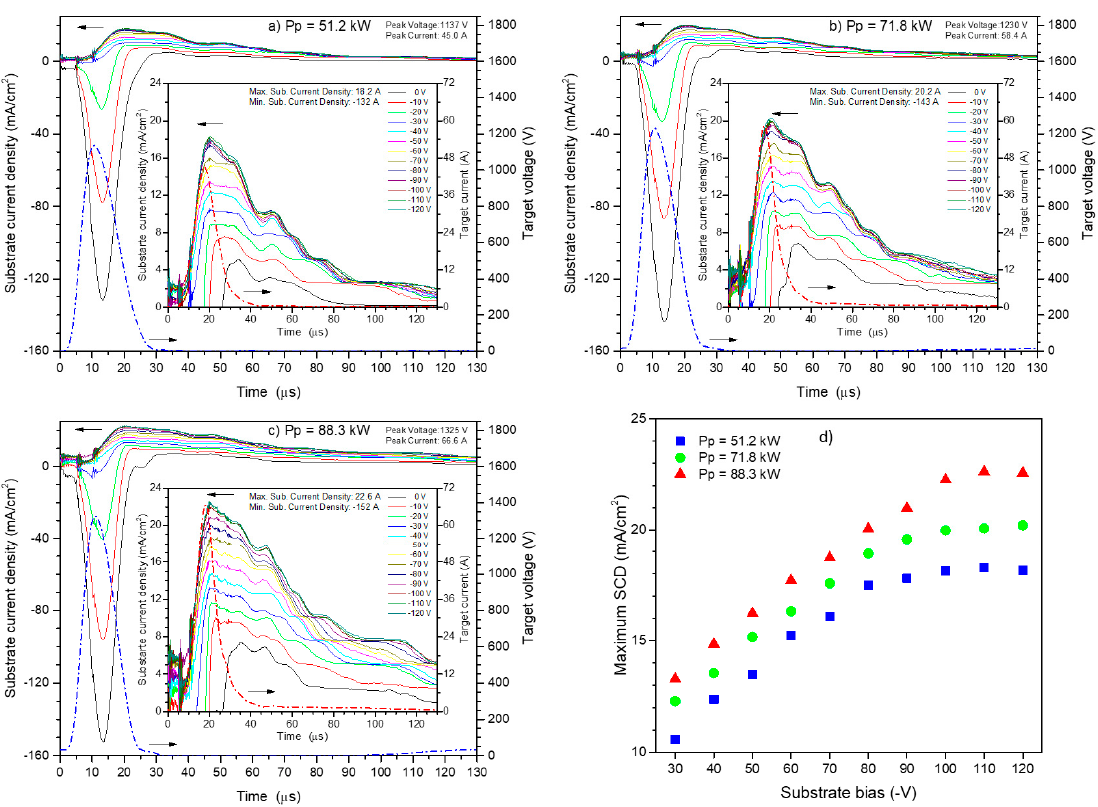
Figure 2. Time-resolved substrate current density (mA / cm 2 ) for substrate biases between 0 and − 120 V obtained with P p = 51.2 kW ( a ), P p = 71.8 kW ( b ), and P p = 88.3 kW ( c ). Maximum of the SCD curves as a function of the peak power and substrate bias ( d ).